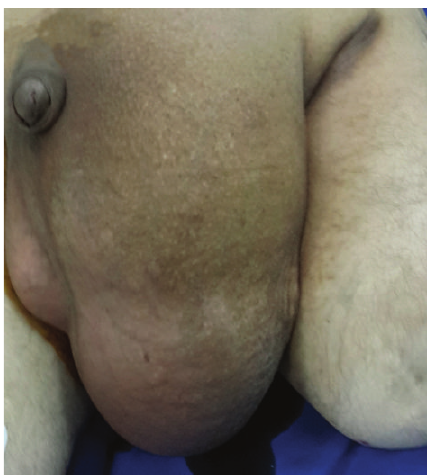
Figure 3: Skin is totally sutured and closed after multiple debride- ment